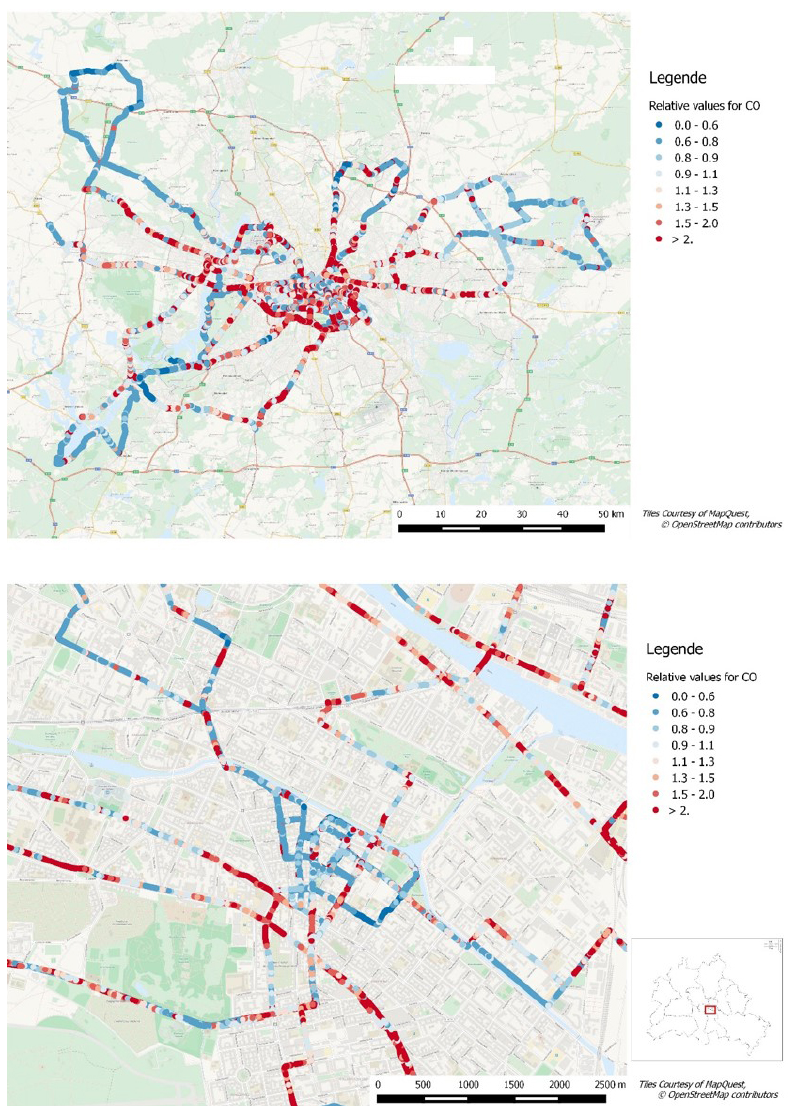
Figure 3. Relative values observed for carbon monoxide in the entire area of study (top) and specifically in Neukölln (bottom). Colors indicate the horizontal heterogeneity and the deviation to the reference in Neukölln. White dots indicate matching values ± 10% the measurements at the reference